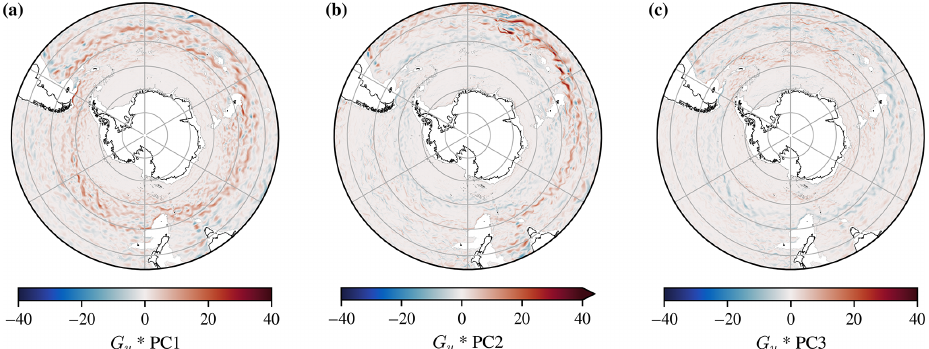
Figure 6. G y Sobel edge operator convolved in two dimensions (*) with the principal component coefficient fields for the month of June 2011. The correlation coefficient between panel (a) for PC1 and the zonal velocity U for the same month in B-SOSE iteration 106 is 0.85, showing that the structure it highlights is substantially similar to the ACC. Panels (b) and (c) for PC2 and PC3 are also related to the ACC, (correlation coefficients of 0.18 and − 0.18 respectively). The grey line is the 2000m